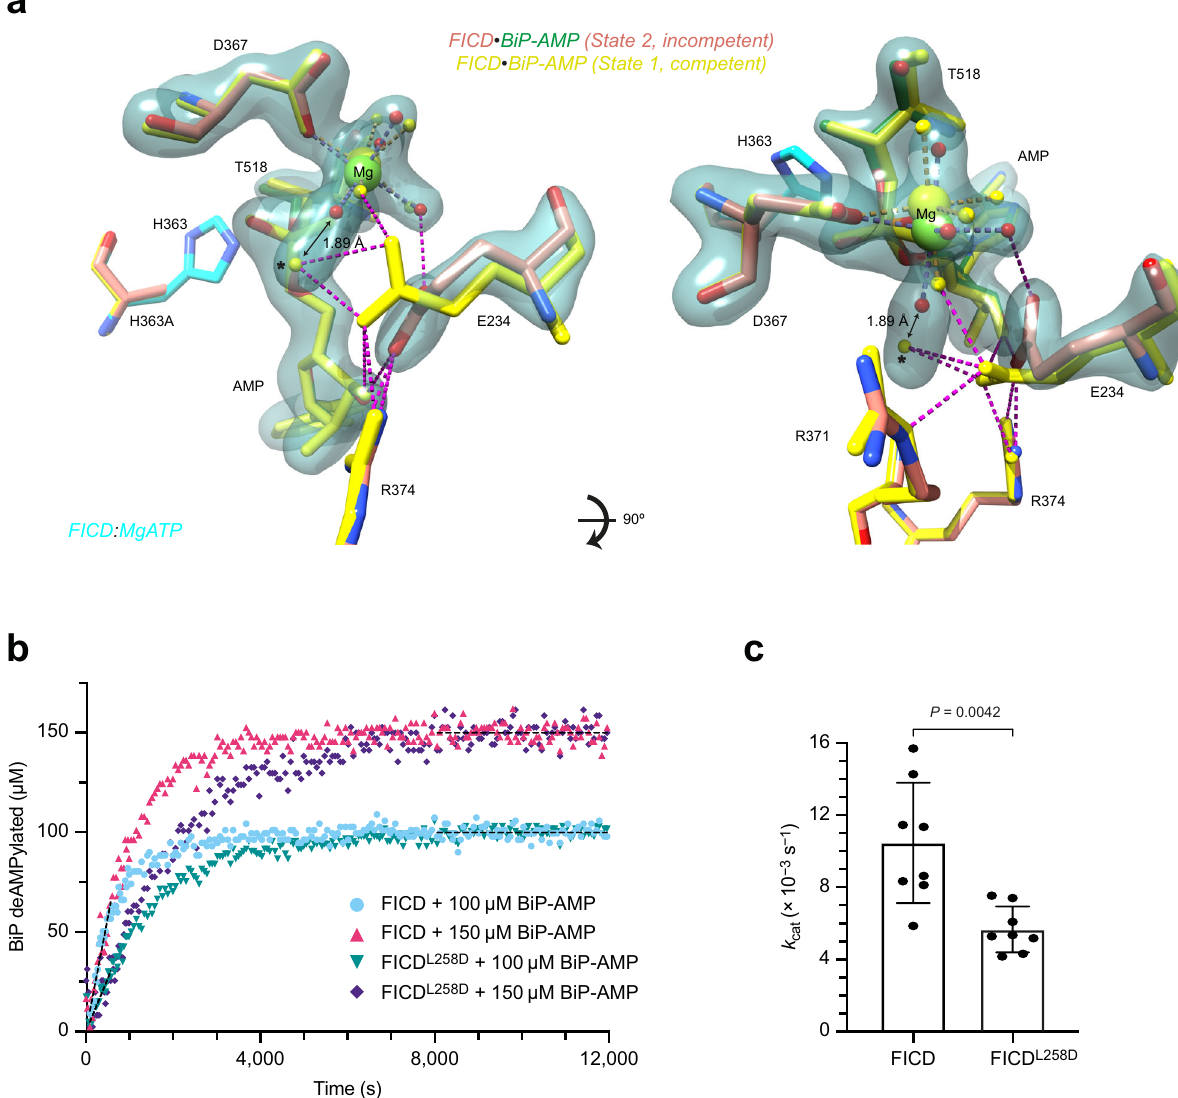
Fig. 7 Monomerisation increases the likelihood of a non-deAMPylation competent Glu234 conformation. a An unbiased polder OMIT electron density map from a second deAMPylation complex structure (state 2), contoured at 6 σ , covering selected Fic domain catalytic residues (orange), the Mg 2 + -coordination complex and BiP ’ s Thr518-AMP (green). The reduced (state 2) active site is aligned with the active site of the (deAMPylation competent) state 1 complex (yellow). His363 is modelled from an alignment of catalytically competent FICD (PDB 6I7K, as in Fig. 6b) 19 .